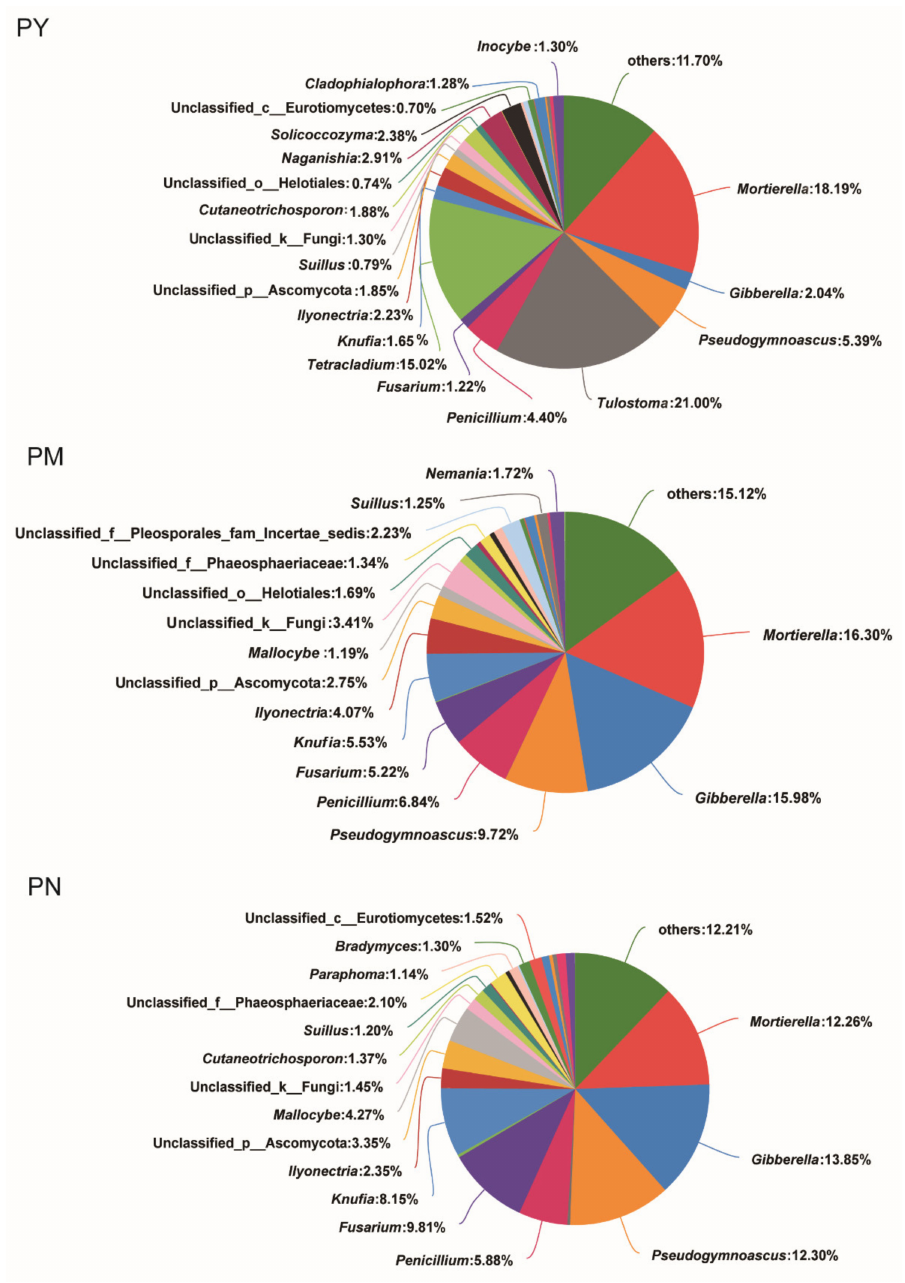
Figure 4. The composition of rhizosphere soil fungi of P. tabuliformis on genus level at different stand ages. PY: young forest (10a), PM: middle-aged forest (20a), and PN: near-mature forest (30a).